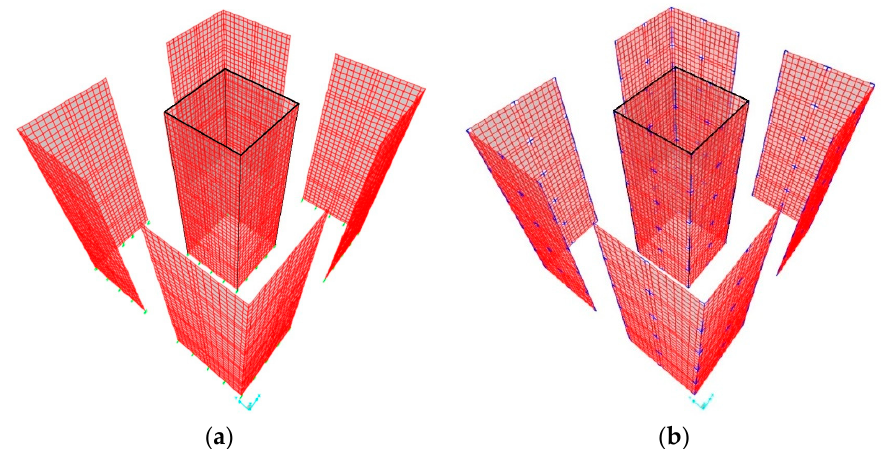
Figure 6. FE models of complete SFRS: ( a ) type A system; ( b ) type B system.